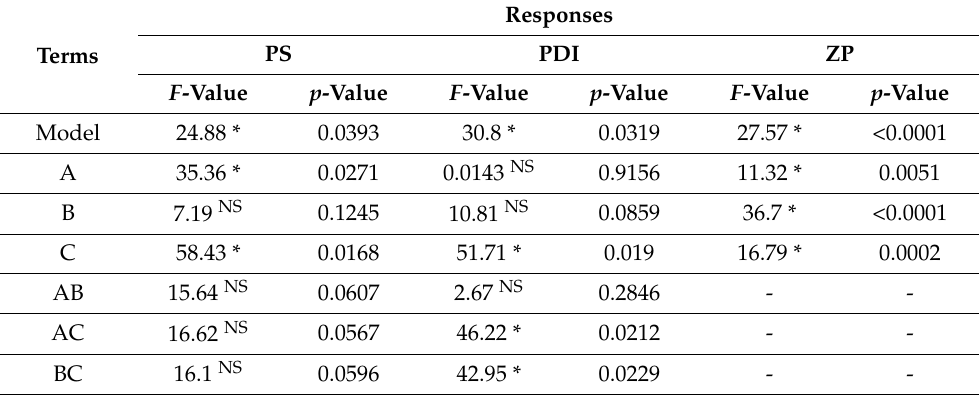
Table 2. ANOVA test results of all responses studied, according to the D-optimal design.